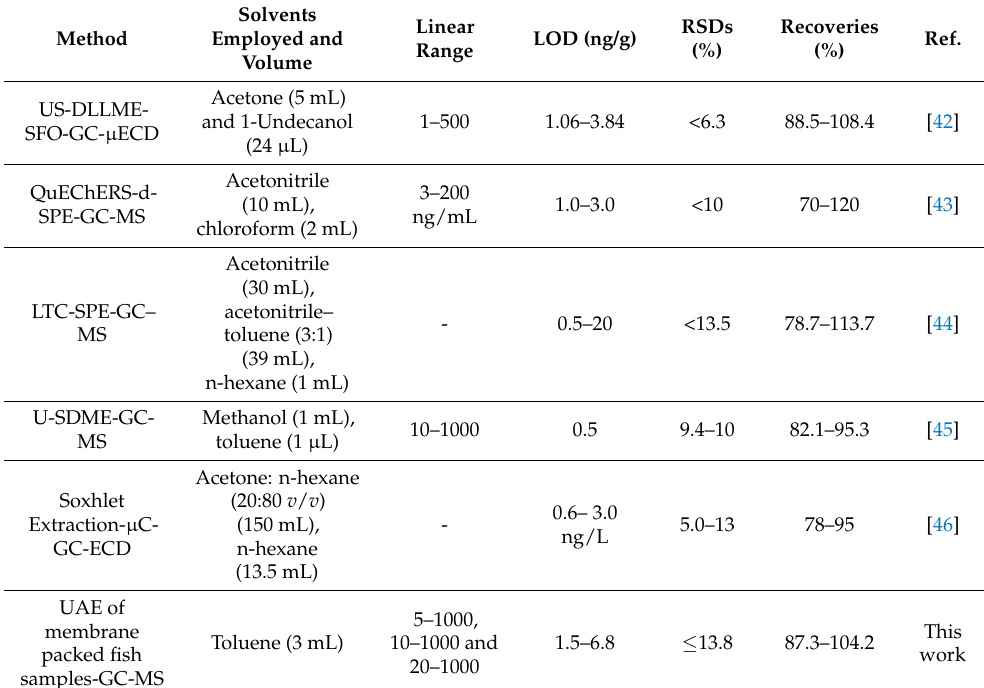
Table 6. Comparison of the current method with those reported in the